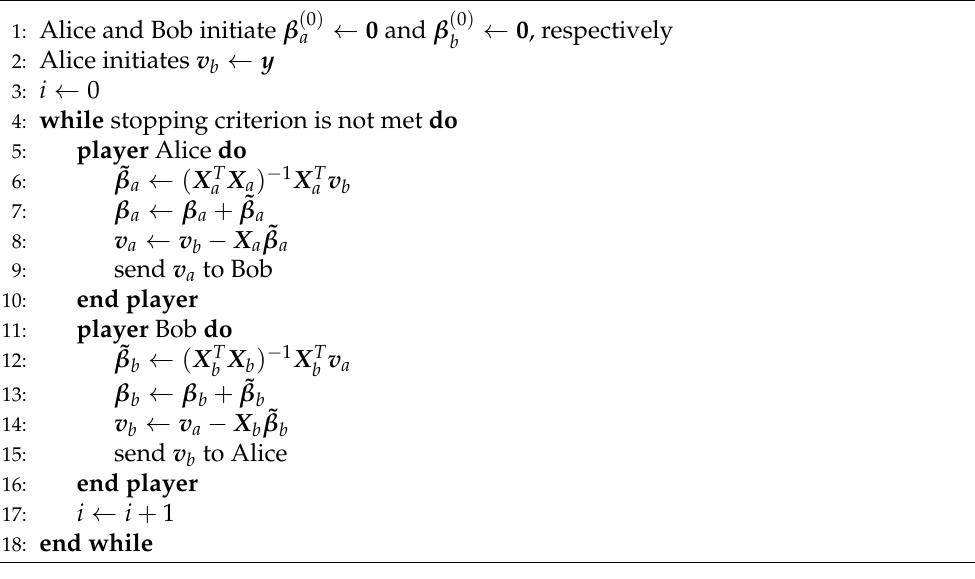
Algorithm 1 Incremental 2-party block coordinate descent algorithm. The subscript a is for Alice and b for